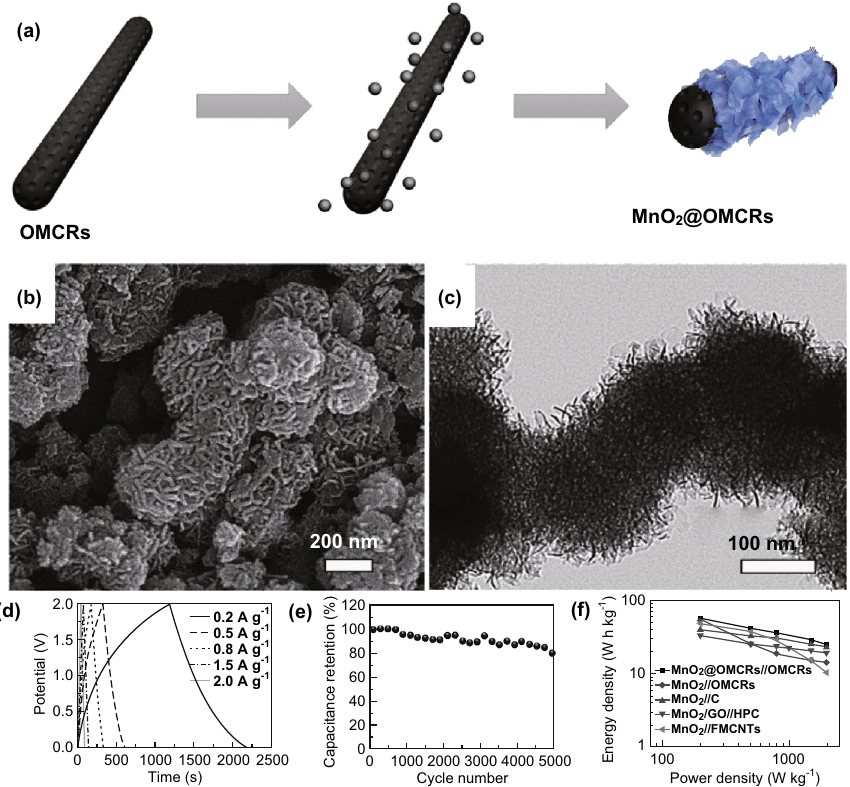
Fig. 3 3D architectures based on 2D MnO 2 nanoflake ensembles for supercapacitors. a Schematic illustration of the process for synthesis of MnO 2 @-ordered mesoporous carbon nanorods. b SEM and c TEM images of MnO 2 @-ordered mesoporous carbon nanorods. d Charge/discharge curves of asymmetric supercapacitor device at different current densities. e Capacitance retention as a function of cycle number at a current density of 2 A g - 1 . f Ragone plots of the present asymmetric supercapacitor devices and other reported MnO 2 -based asymmetric supercapacitor devices. Reproduced with permission [69]. Copyright (cid:2) 2016, John Wiley & Sons,